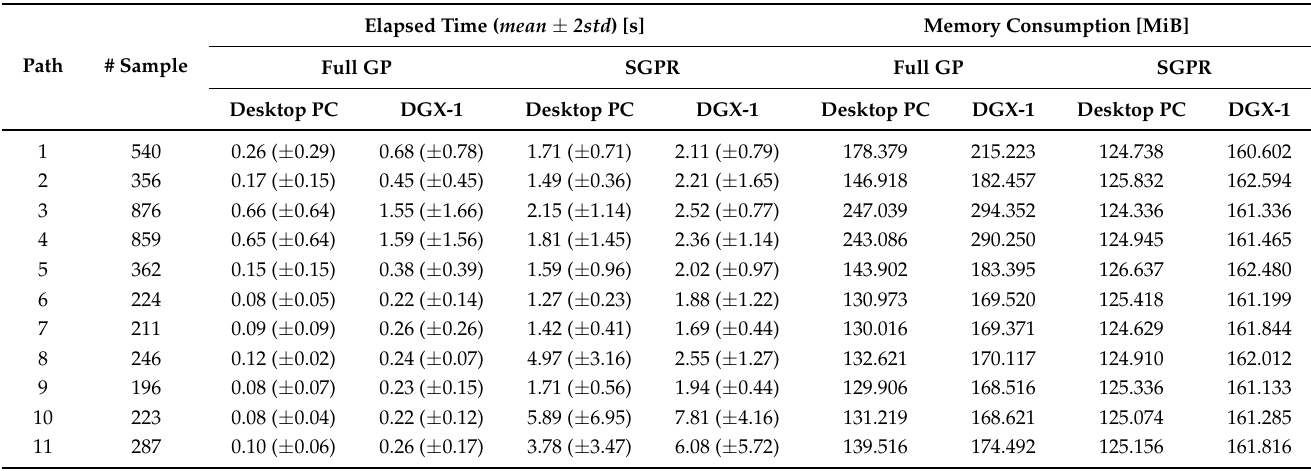
Table 1. Learning time and memory consumption when using the Gaussian process for publicly available magnetic data [41]. The hardware used in this case is shown in Table 2.